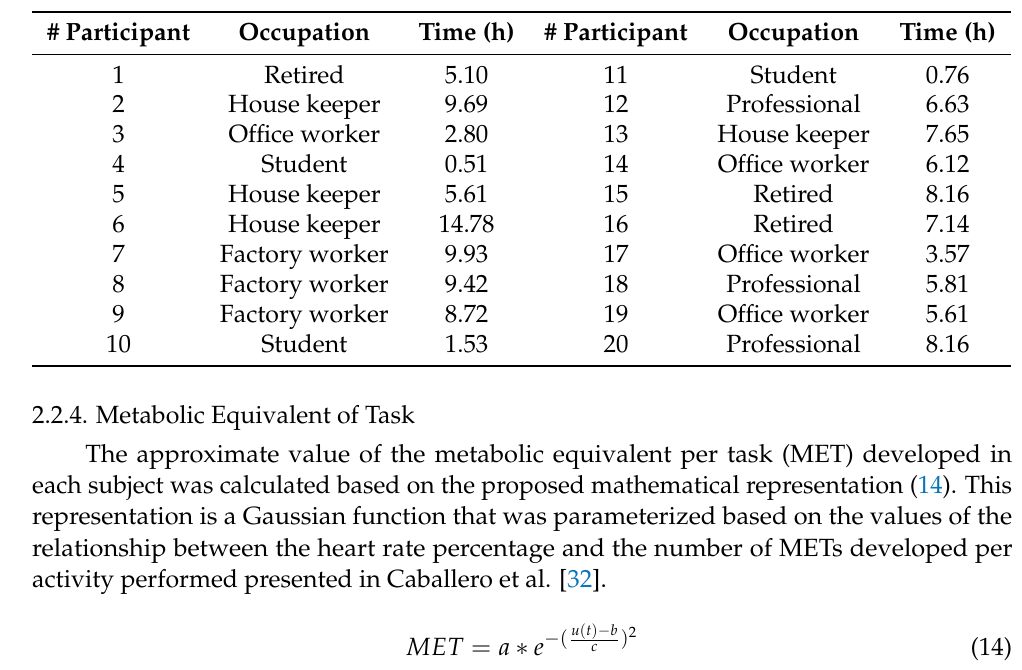
Table 3. Occupation of participants and activity